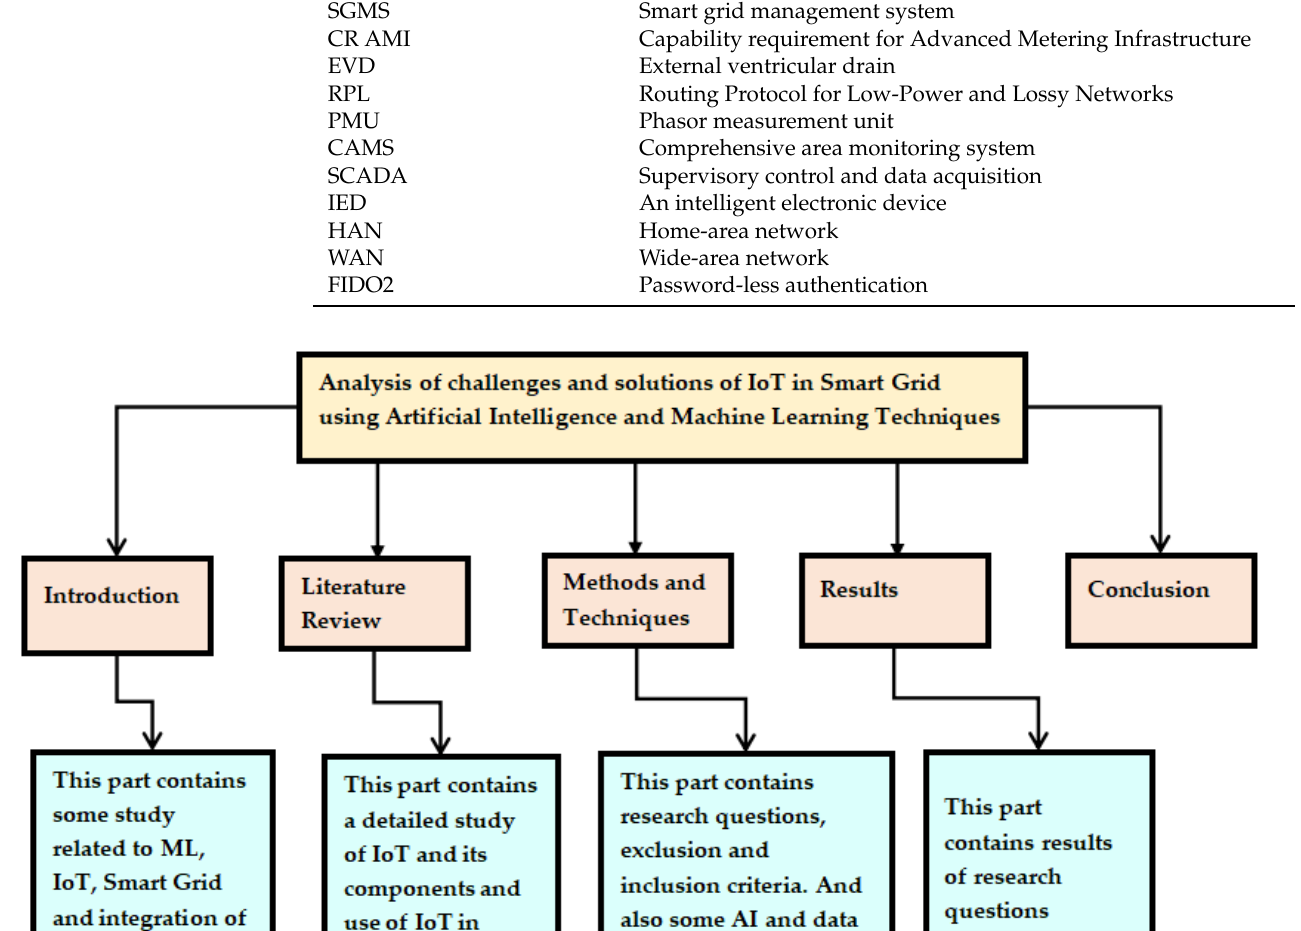
Figure 1. Taxonomy of the proposed work.